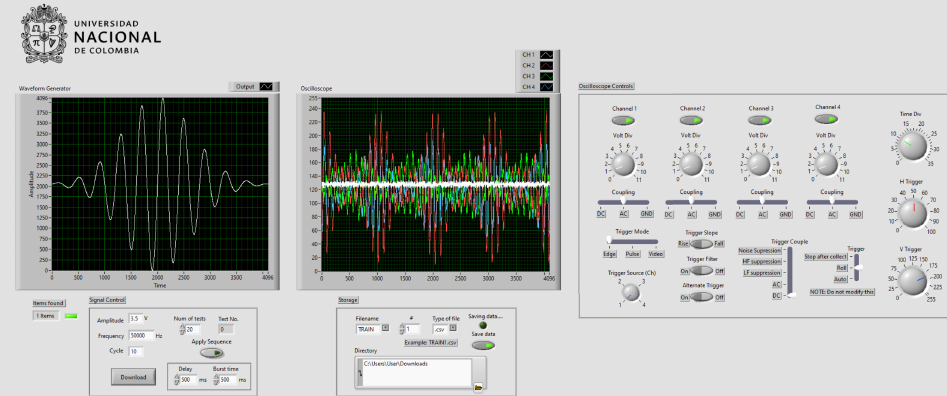
Figure 2. Graphical interface of the Hantek 6104BD control software.